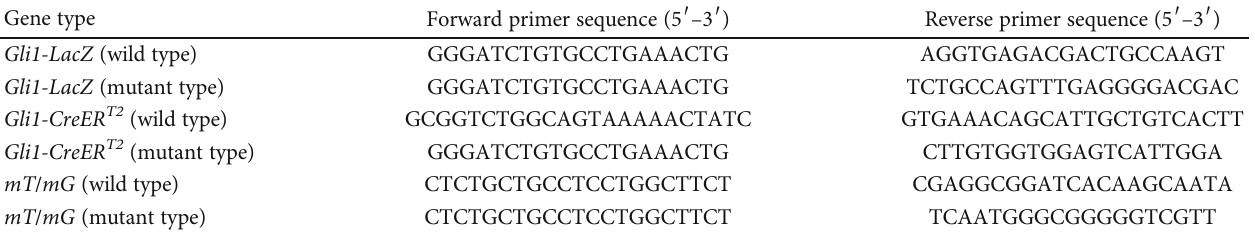
Table 1: Primers used for gene